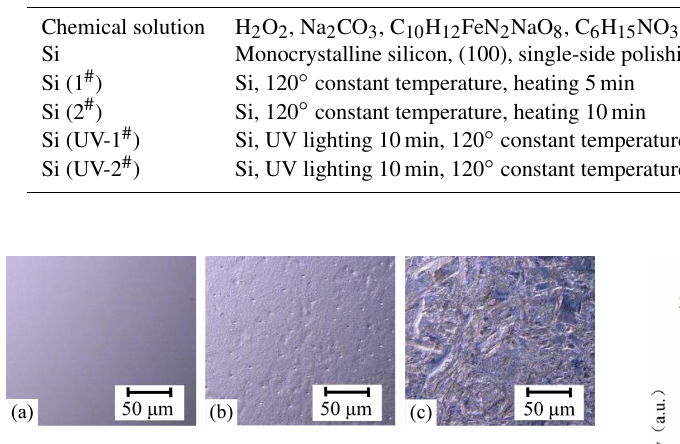
Figure 2. The microscopic surface morphology of (a) Si, (b) Si (2 # ), and (c) Si (UV-2 # ).